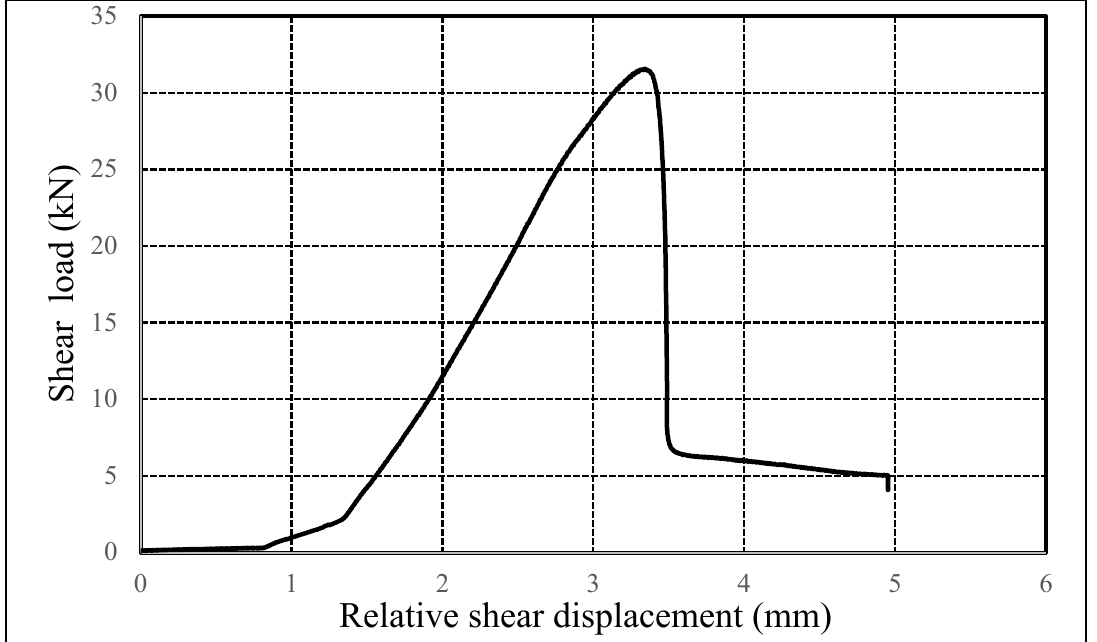
Figure 3. The relationship between interlayer shear load and relative shear displacement.